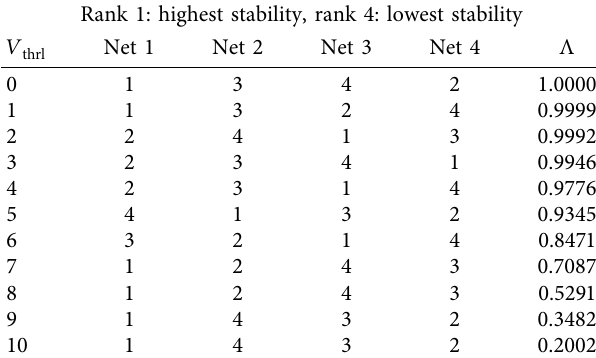
Table 4: Ranking of networking according to stable state level and effect on network activities as a function of threshold.